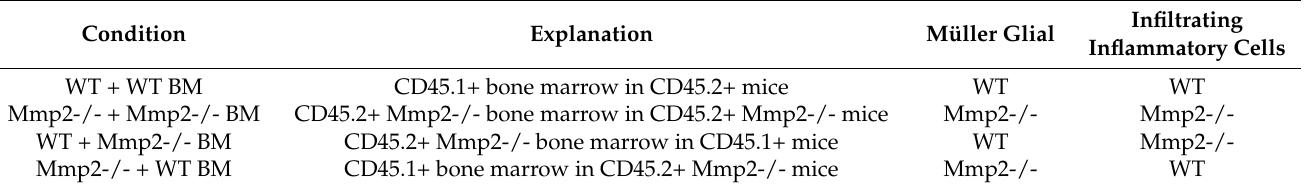
Table 1. Schematic overview of the different conditions for bone marrow transplantations and the resulting cellular genotypes. BM: bone marrow, WT: